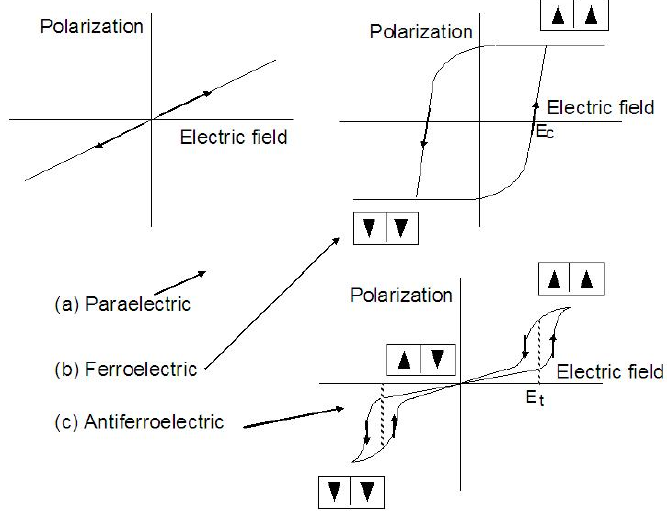
Figure 4. Electric field vs. induced polarization curves in: paraelectric ( a ); ferroelectric ( b ); and antiferroelectric ( c ) materials.